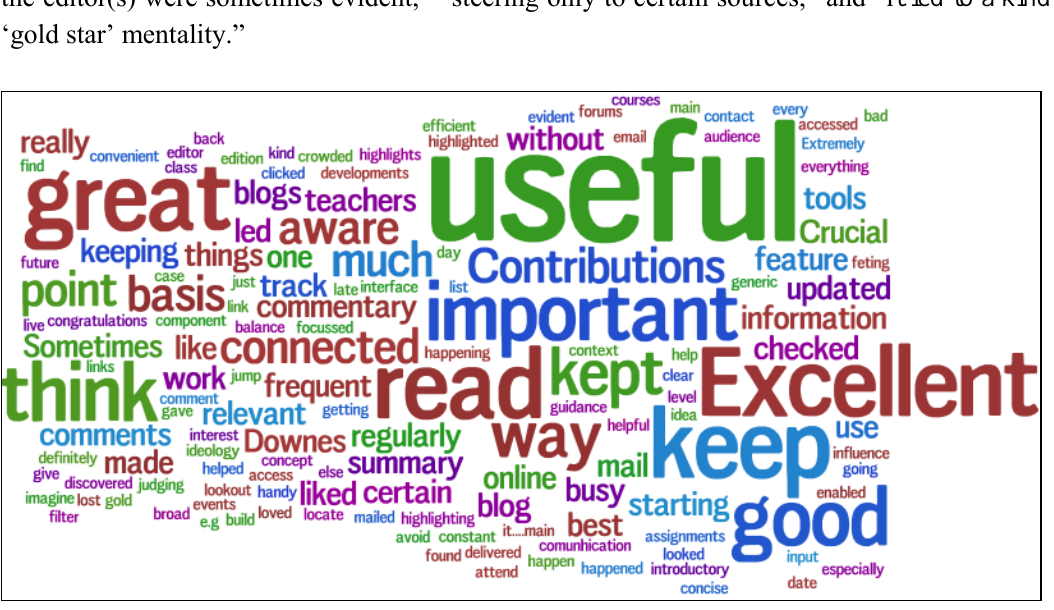
Figure 8 . The tag cloud from comments on the